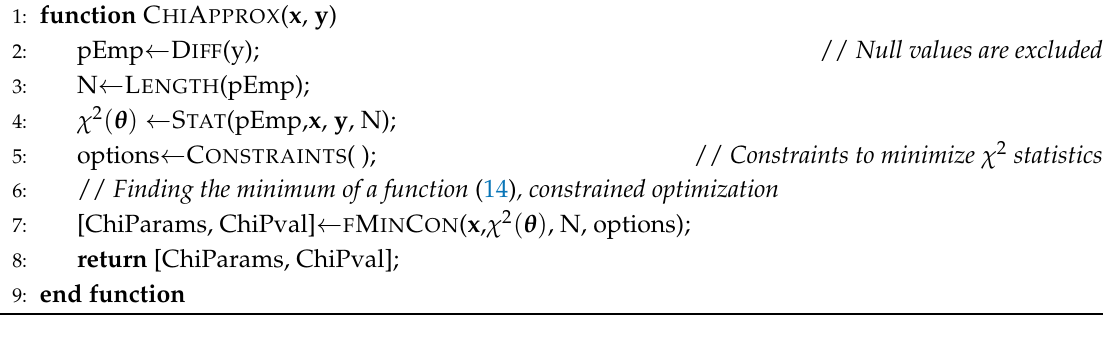
Algorithm A2. Estimation of the mixture parameters by the method of minimizing χ 2 estimates